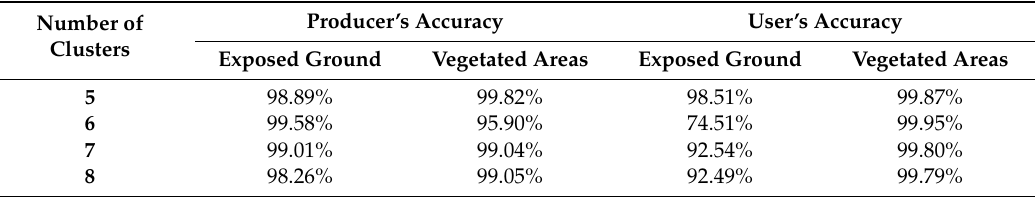
Table 9. Summary of the quantitative assessment of UAS-SfM segmentation results for exposed ground and vegetated areas when increasing the number of